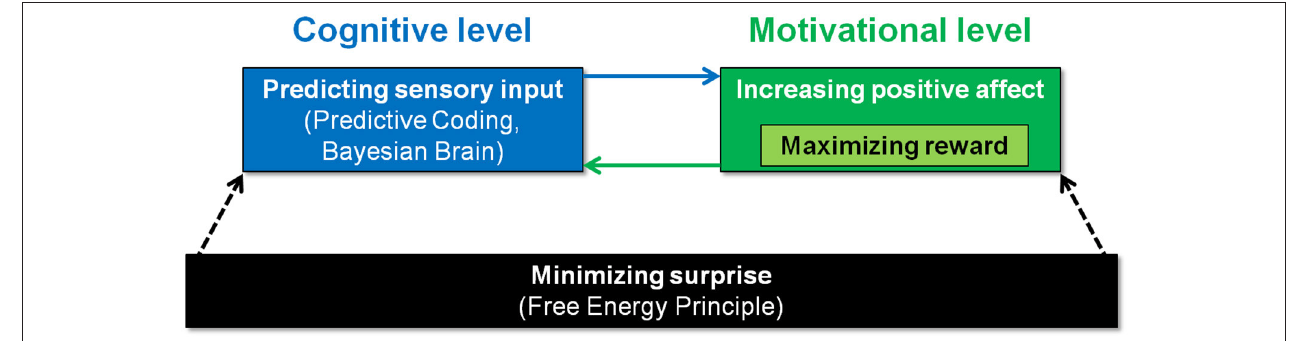
FIGURE 1 | Possible goal hierarchy of biological organisms. At the bottom of the hierarchy, organisms may be driven by surprise minimization (Friston, 2010). On the level of implementation, this may require organisms (i) that apply the principles of predictive coding/Bayesian statistics (Rao and Ballard, 1999; Knill and Pouget, 2004), and (ii) that are driven by the motivation to increase positive affect. Successful predictions possibly elicit positive affect (Chetverikov and Kristjánsson, 2016). Conversely, the motivation to increase positive affect may promote prediction of sensory